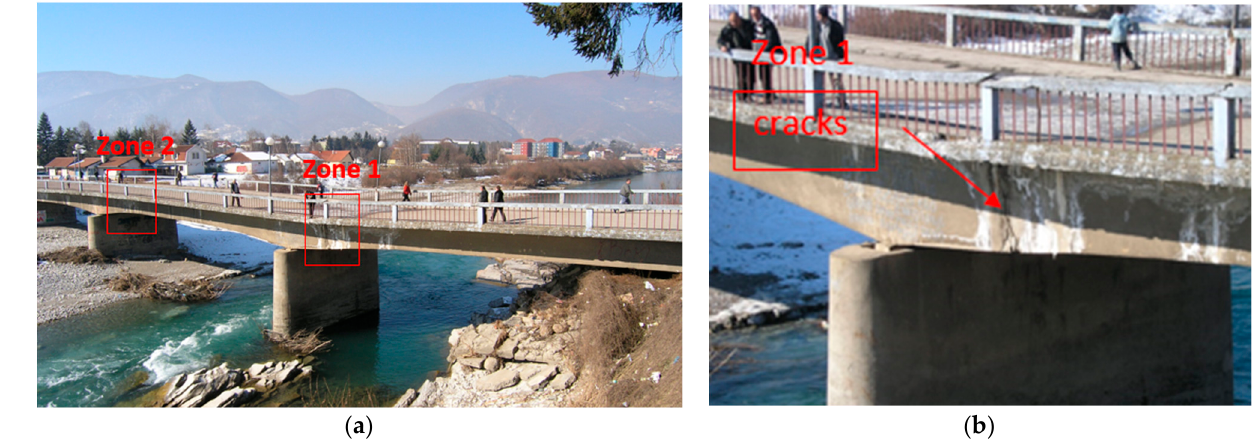
Figure 5. ( a ) The bridge after the settlement of the river pier and ( b ) cracks in zone 1.